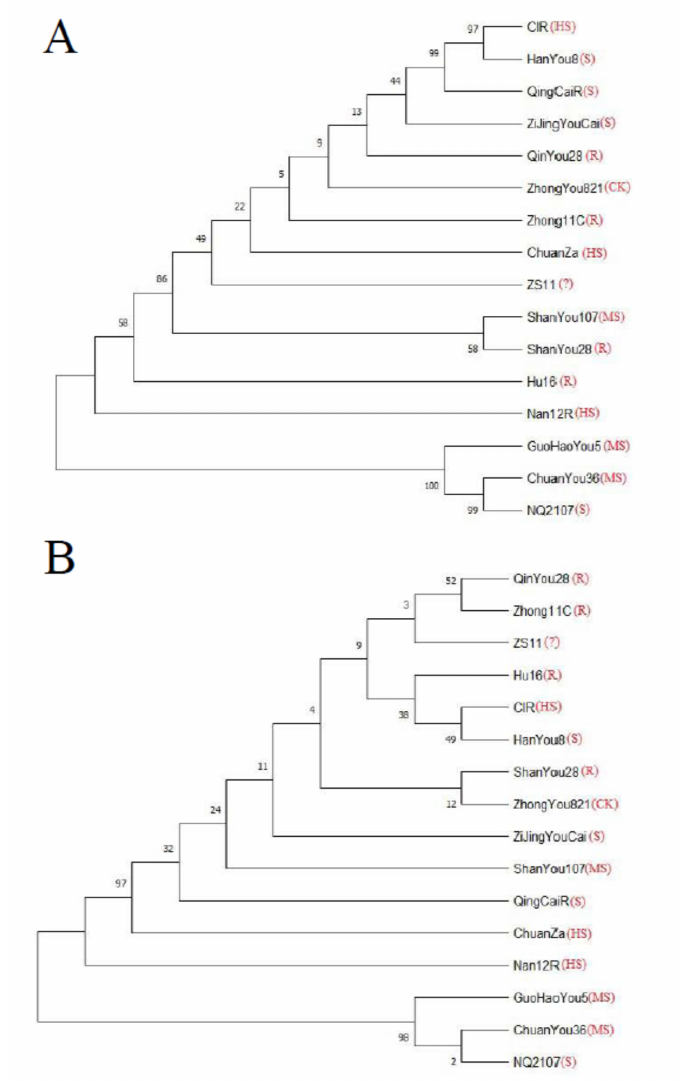
Figure 3. The evolutionary tree of BnP5CR2 gene; ( A ) based on gene sequence; ( B ) based on CDS. “?” means that the disease resistance of Z11 is